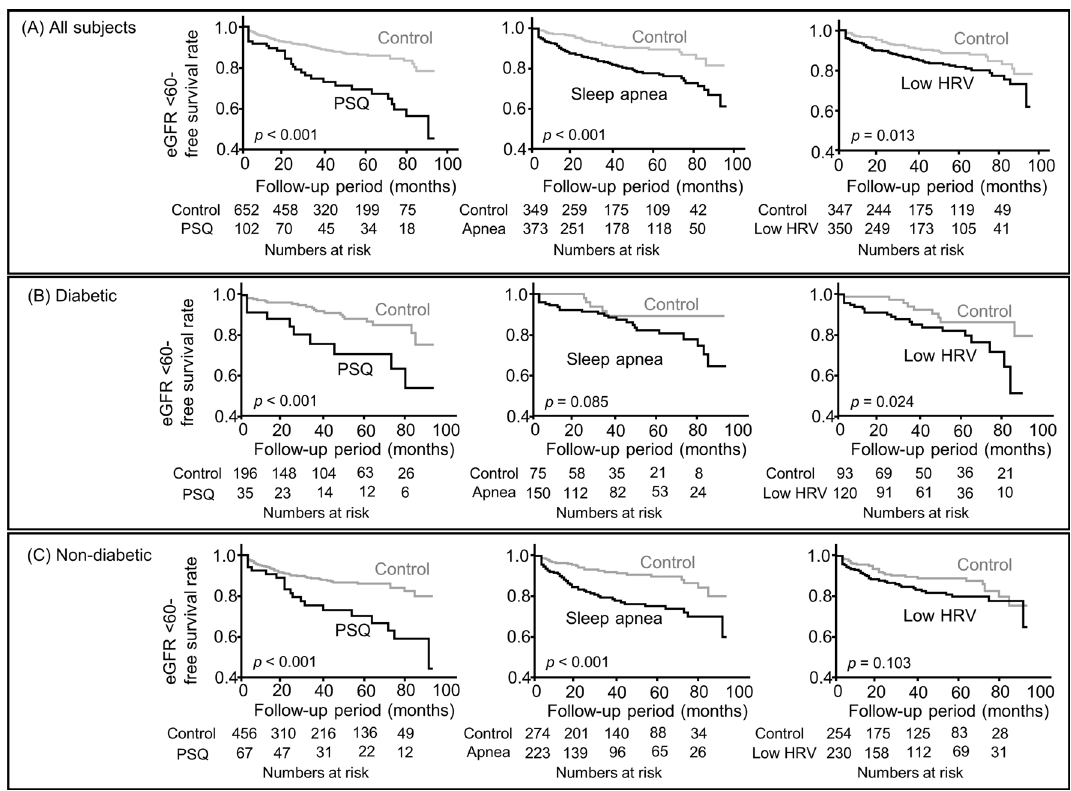
Figure 2. Kaplan–Meier analysis of associations of PSQ, sleep apnea, and autonomic nervous function with renal function decline in diabetic and non-diabetic patients. Subjects in the diabetic and non-diabetic groups were compared based on the presence or absence of PSQ, sleep apnea, and low HRV. Probability was analyzed using a log-rank test. PSQ poor sleep quality, HRV heart rate